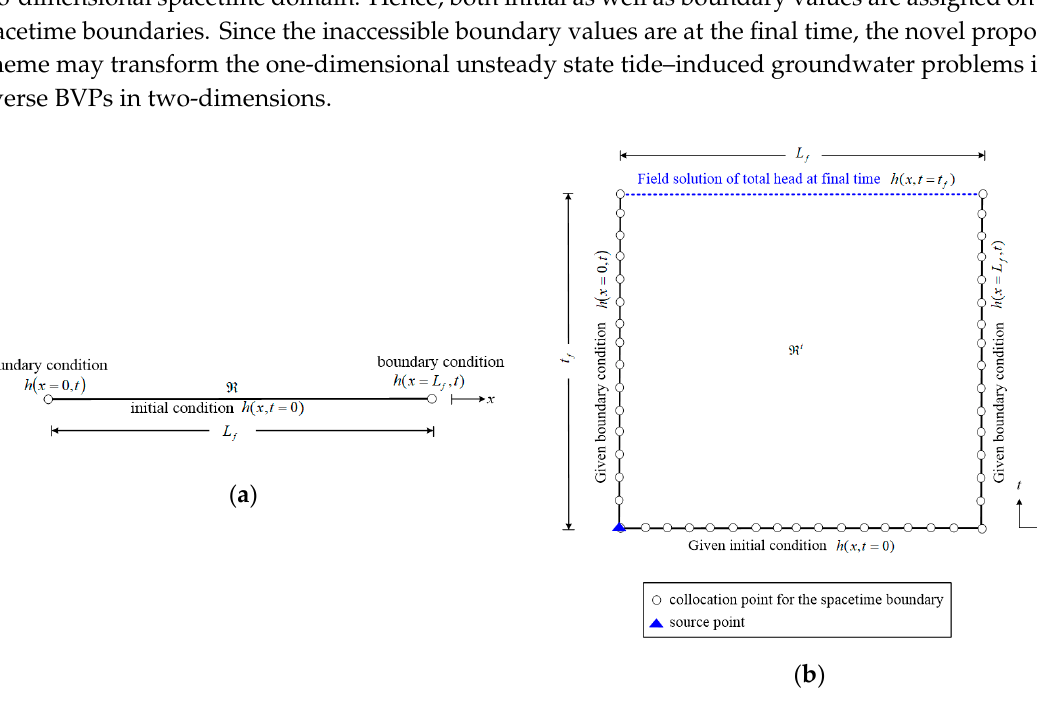
Figure 2. Conventional one-dimensional domain and the spacetime domain: ( a ) conventional one-dimensional transient problem; ( b ) boundary points of the problem in the spacetime domain.